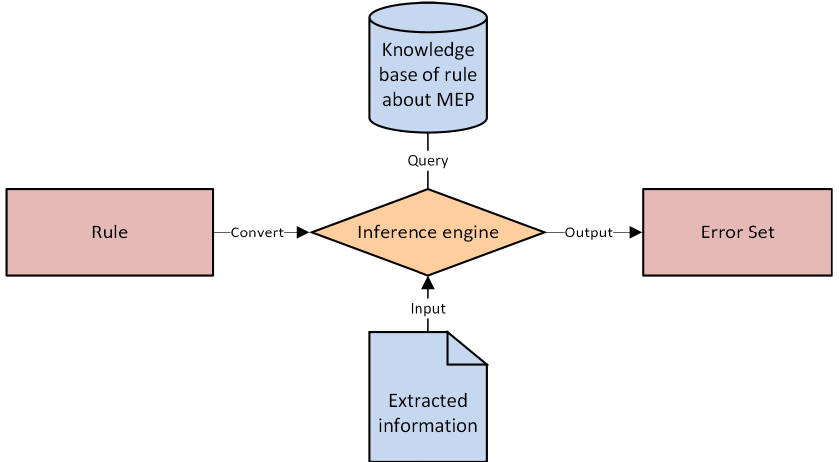
Figure 9. Implementation of the rule execution phase.